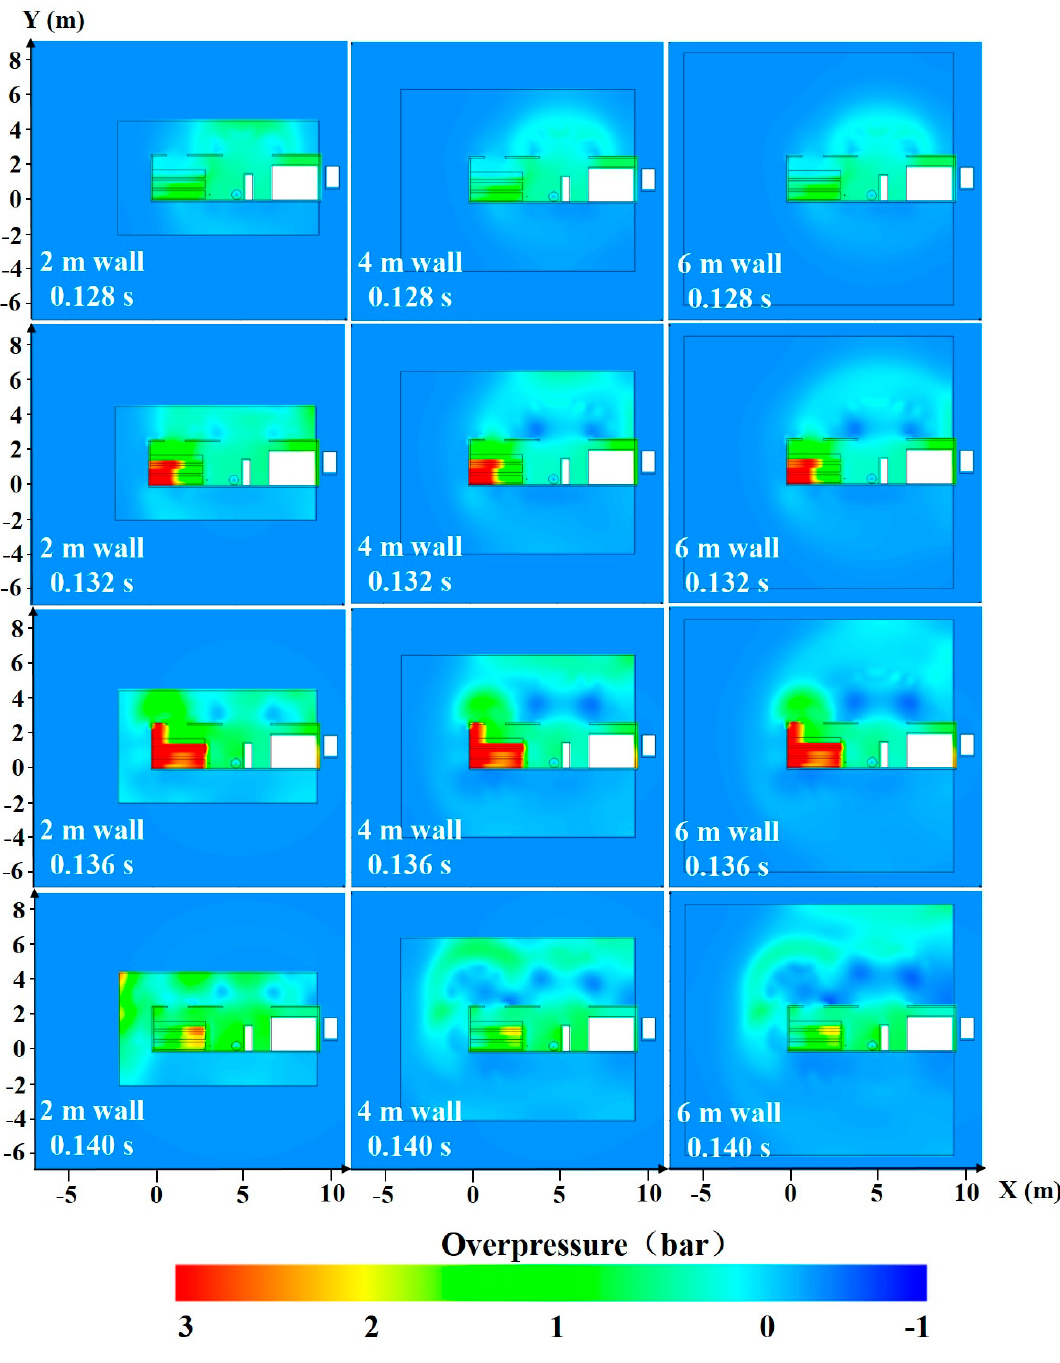
could reduce the maximum overpressure on the side of the container by 84.7%, as shown in Figure 11b. The maximum overpressures were 0.30 bar inside the wall and 0.05 bar outside the wall when the distance of the protective wall was 6 m. Setting a protective wall at a distance of 6 m could reduce the maximum overpressure on the side of the container by 81.4%, as shown in Figure 11c. The protective walls can reduce the overpressure damage outside the wall to a safe range.